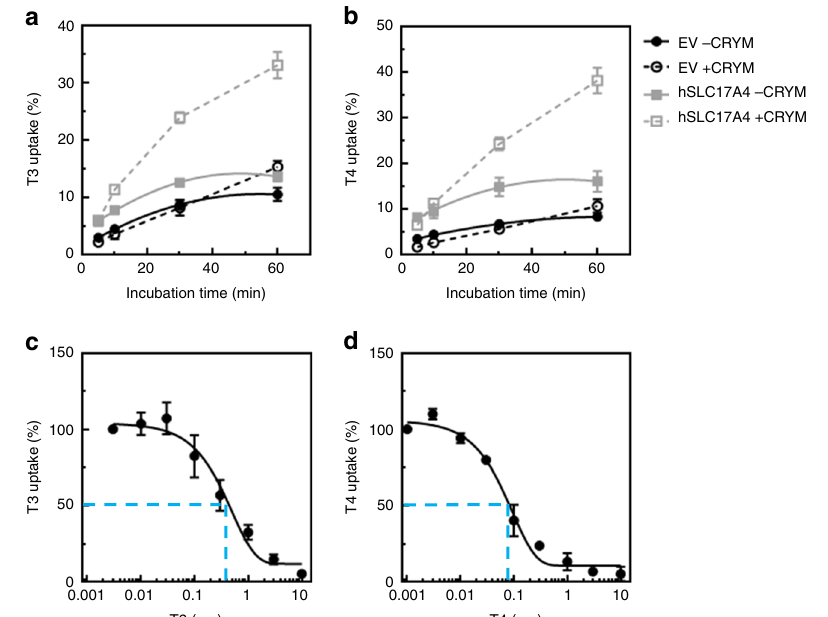
Fig. 3 Thyroid hormone transport by hSLC17A4. Cellular T3 ( a ) and T4 ( b ) accumulation in COS-1 cells, transiently transfected with empty vector (EV), or wild-type hSLC17A4 in the absence (solid lines) or presence (dashed lines) of the intracellular thyroid hormone-binding protein CRYM, after indicated incubation times at 37 °C. All uptake levels are expressed relative to the amount of radio-labeled T3 or T4 added to the cells at the start of the incubation (1 nM (5 × 10 E 4 c.p.m.) [ 125 I]-T3 or [ 125 I]-T4). All results are presented as means± SEM ( n = 4). In the presence and absence of CRYM, T3 and T4 accumulation in hSLC17A4 transfected cells was signi fi cantly higher compared to empty-vector control cells at all time points (one-way ANOVA with a Bonferroni-corrected post hoc test, p < 0.001). T3 ( c ) and T4 ( d ) saturation curves in COS-1 cells transiently transfected with hSLC17A4 in the absence of CRYM. All data points are corrected for background thyroid hormone uptake in control cells and presented relatively to the amount of internalized thyroid hormone in the presence of the lowest substrate concentration (0.003 µ M for T3 and 0.001 µ M for T4, respectively). Apparent IC 50 values were determined by standard second order polynomial regression analyses implemented in GraphPad Prism (La Jolla,